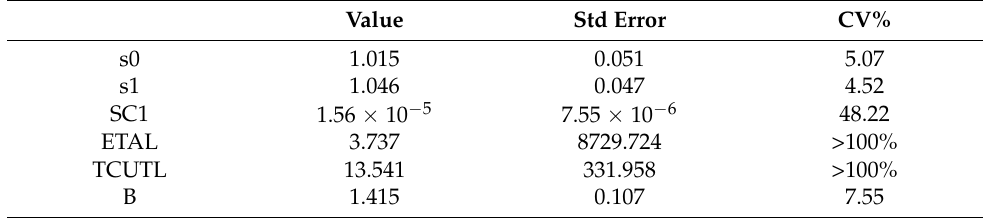
Table 8. Parameters (and their standard error and coefficient of variation) of the IVIVC developed with 4